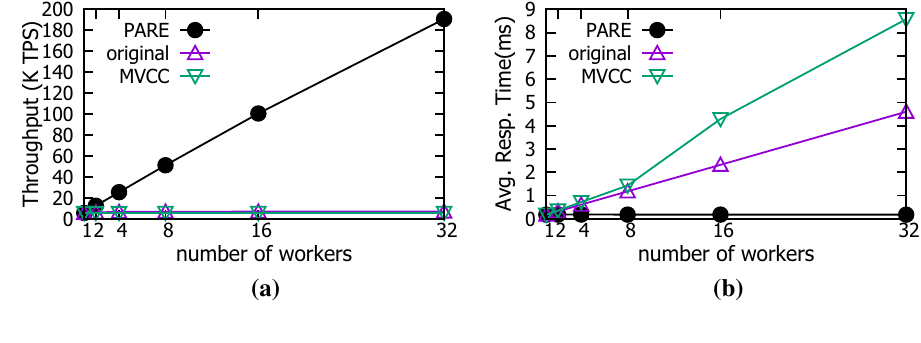
Fig. 3 Performance comparison under extremely contended HFT workloads. a Throughput, b average response